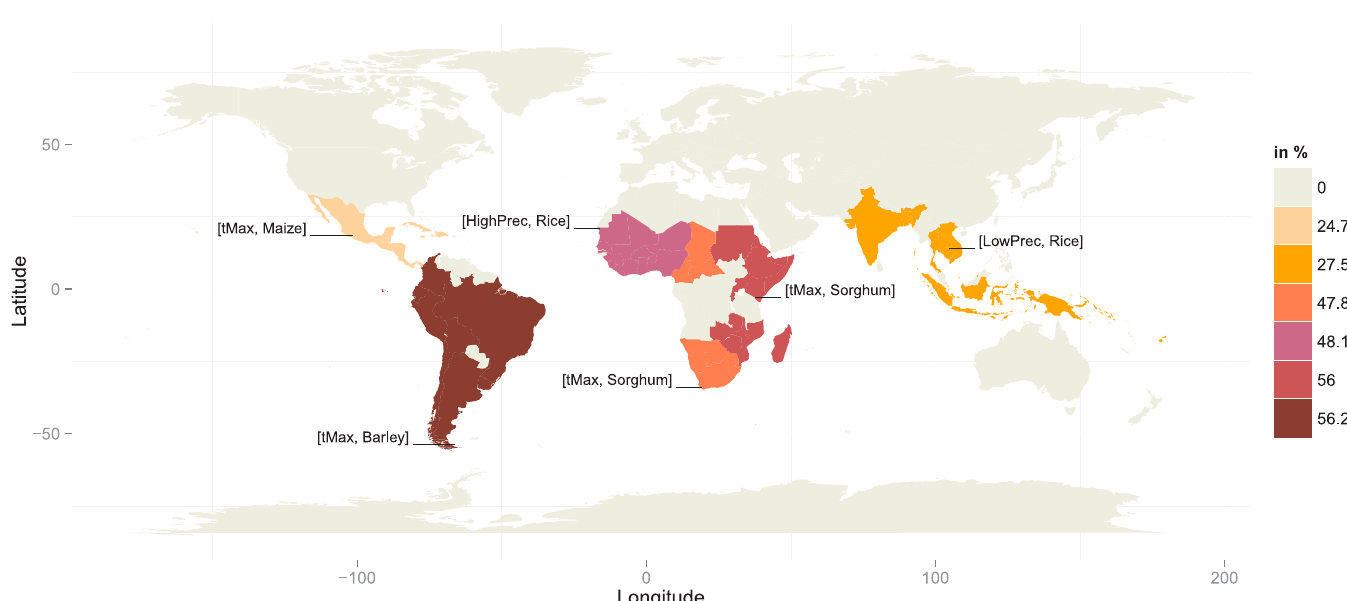
Fig 5. Worst-case scenario: The maximum upper bound of the 95% confidence interval of the conditional probability estimates, i.e. the probability estimates of yield losses above the 90 th quantile given minimum temperature, maximum temperature or high precipitation extremes above the 98 th quantile or low precipitation extremes below the 2 nd